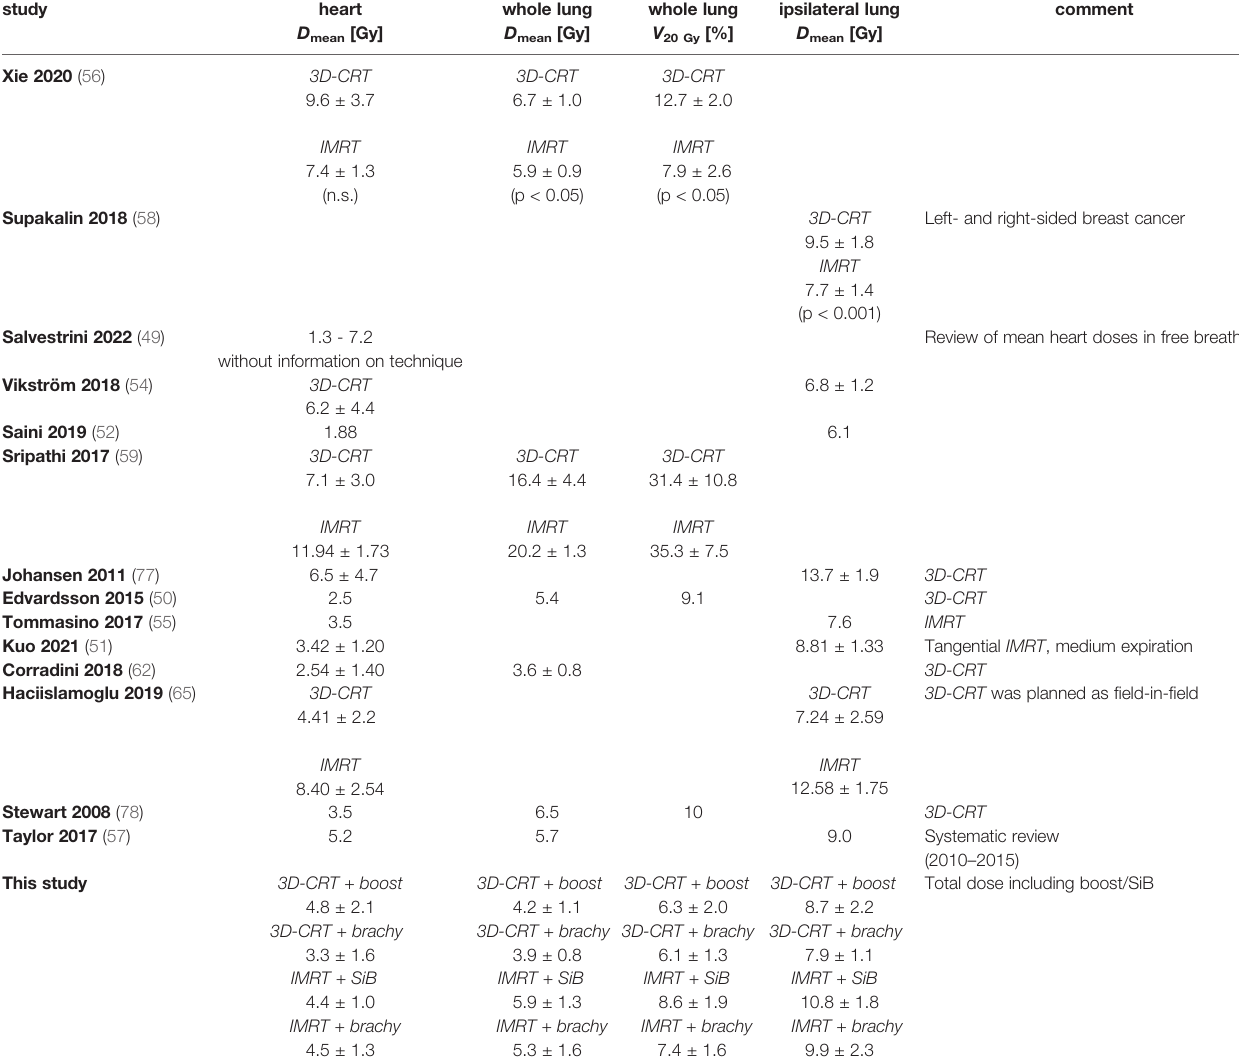
TABLE 6 | Recent fi ndings in literature compared to our results.